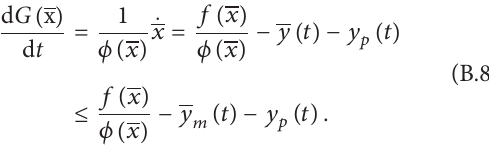
Figure 8: Basin of attraction of two attractors shown in Figure 6. The range of 0.01 ≤ 𝑥 ≤ 35 is on the horizontal axis, 0.01 ≤ 𝑦 ≤ 100 is on the vertical axis; the parameters are identical to Figure 6. The white and black points are attracted to the attractor shown in Figure 6 from left to right,